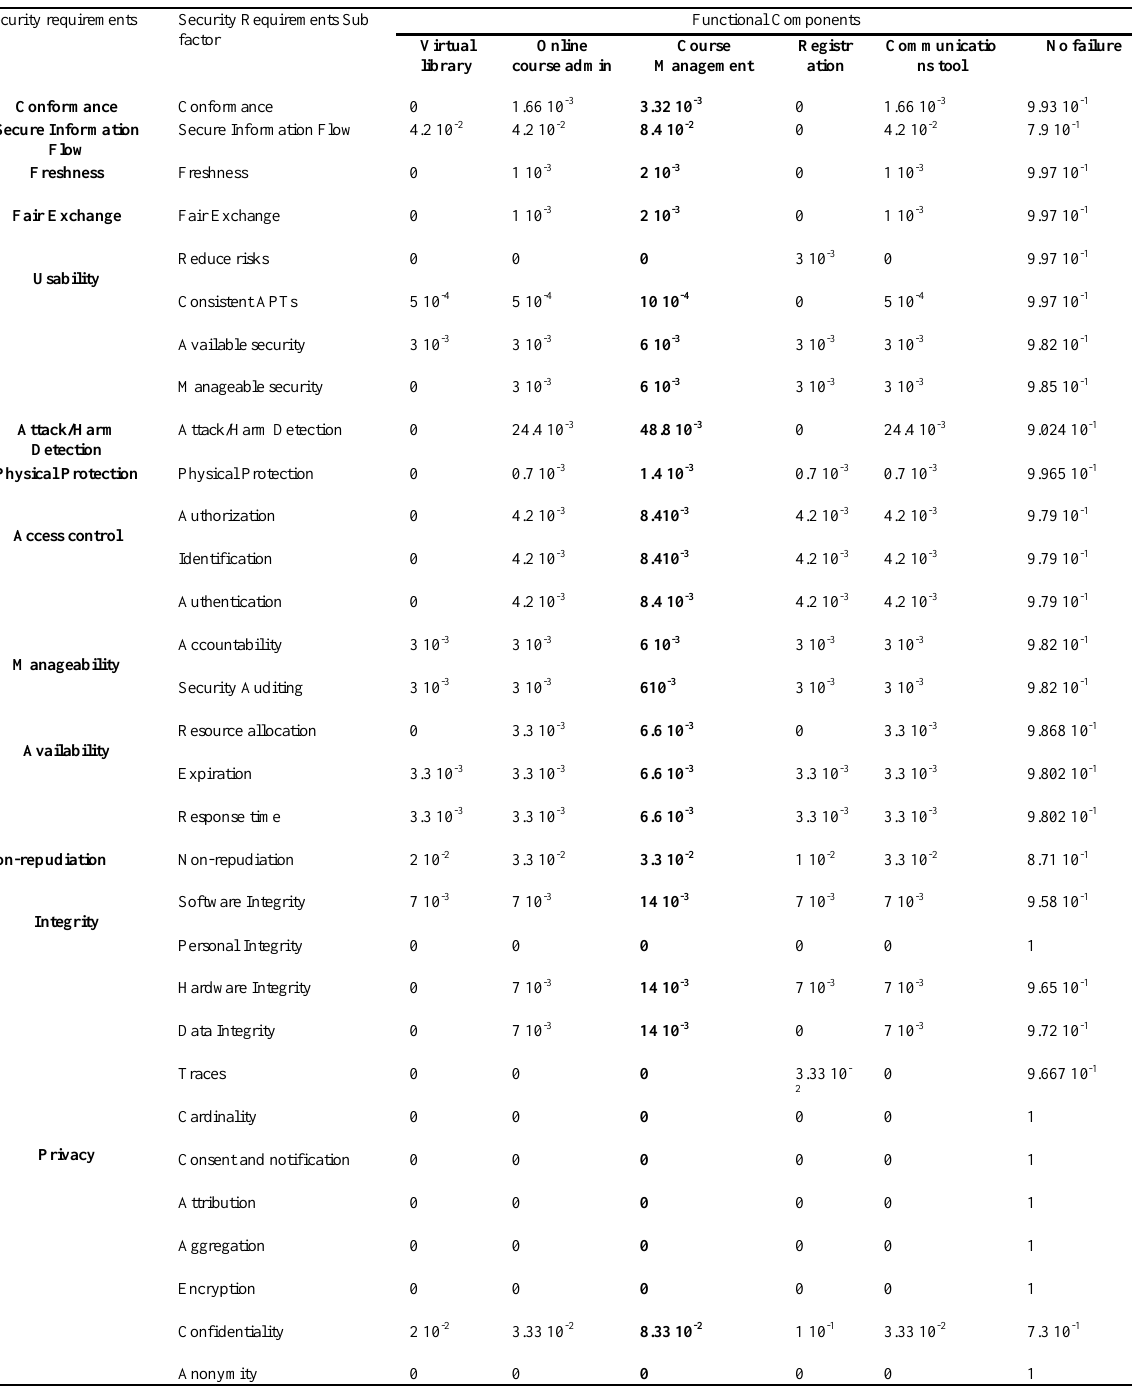
Table 3: The RFC